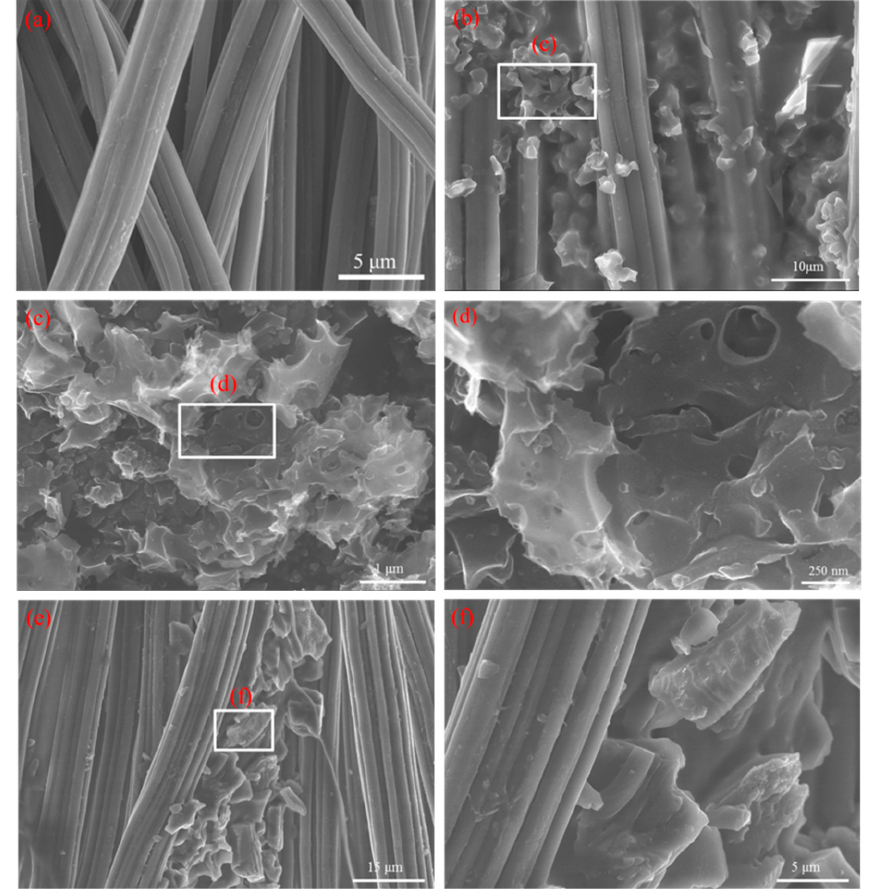
Figure 1. SEM images of ( a ) the carbon cloth (CC), ( b , c and d ) the self-doped-nitrogen porous carbon nanosheets (N-CNS)-CC and ( e , f ) the unactivated self-doped-nitrogen porous carbon nanosheets